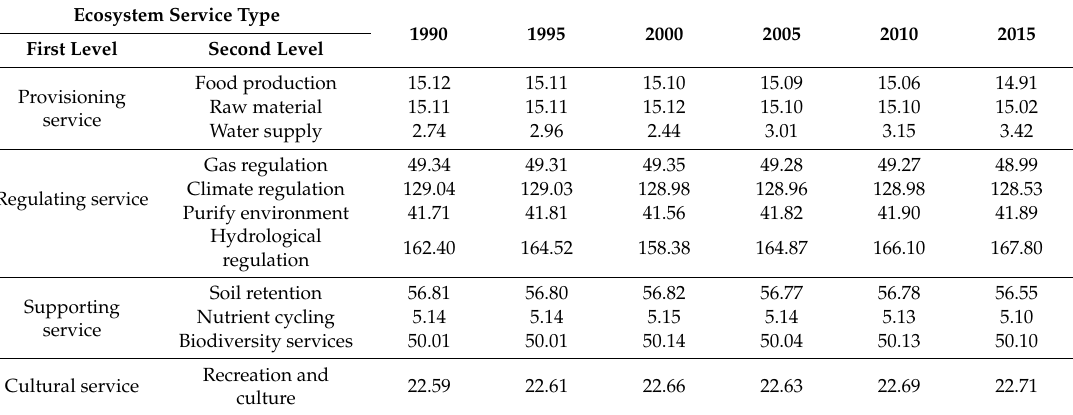
Table 2. Ecosystem service values in 1990–2015 (billion